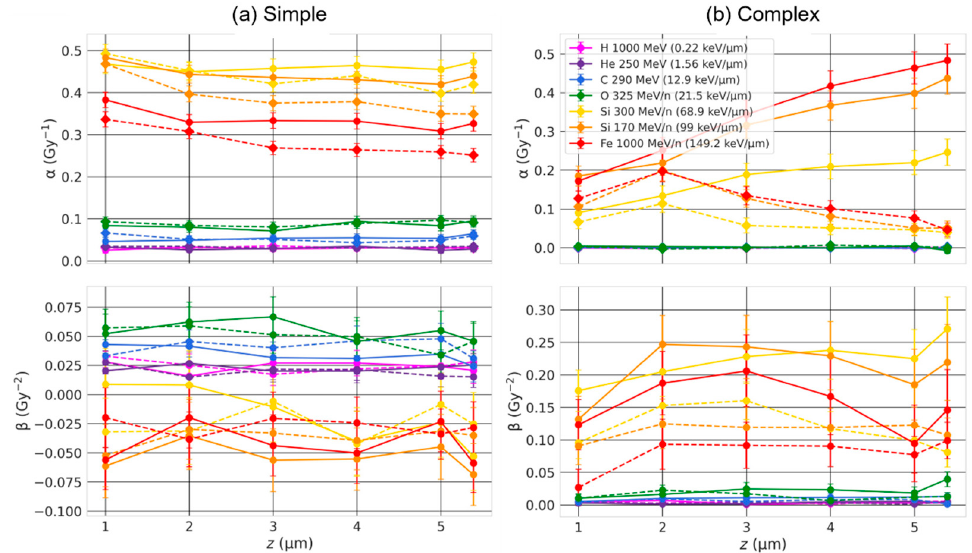
Figure 8. 𝛼 and 𝛽 coefficients of simple ( a ) and complex ( b ) exchanges as a function of the cell thickness, for 82-6 cell line (V = 656 μ m 3 ), and for ion beams of varying LET. Straight lines were added between RITCARD datapoints to help visualization. Solid line with round symbols: without chromosome domain constraint. Dashed line with diamond symbols: with chromosome domain constraint.